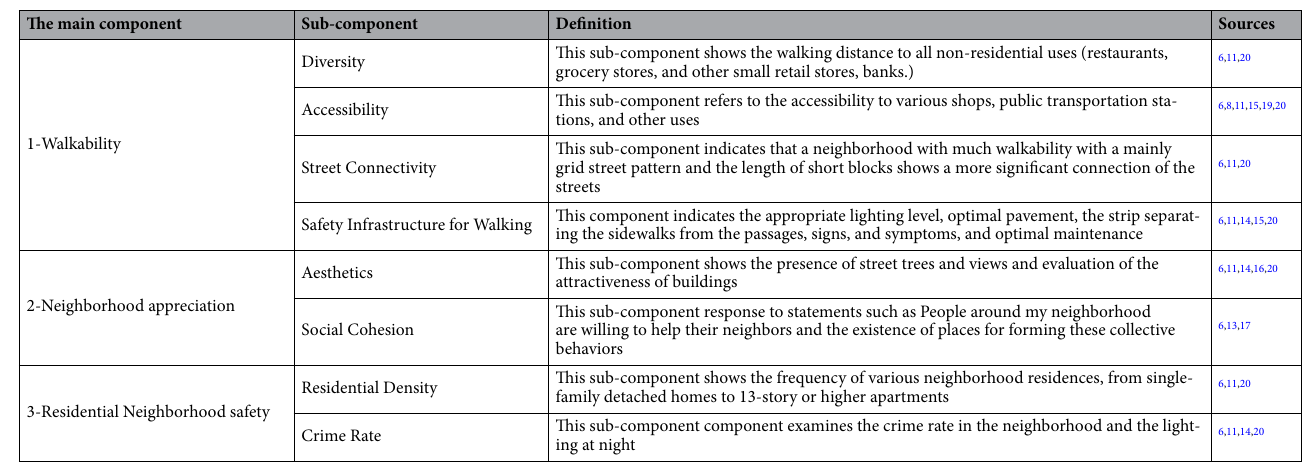
Table 2. Explaining the main components of perceived evaluation of the neighborhood